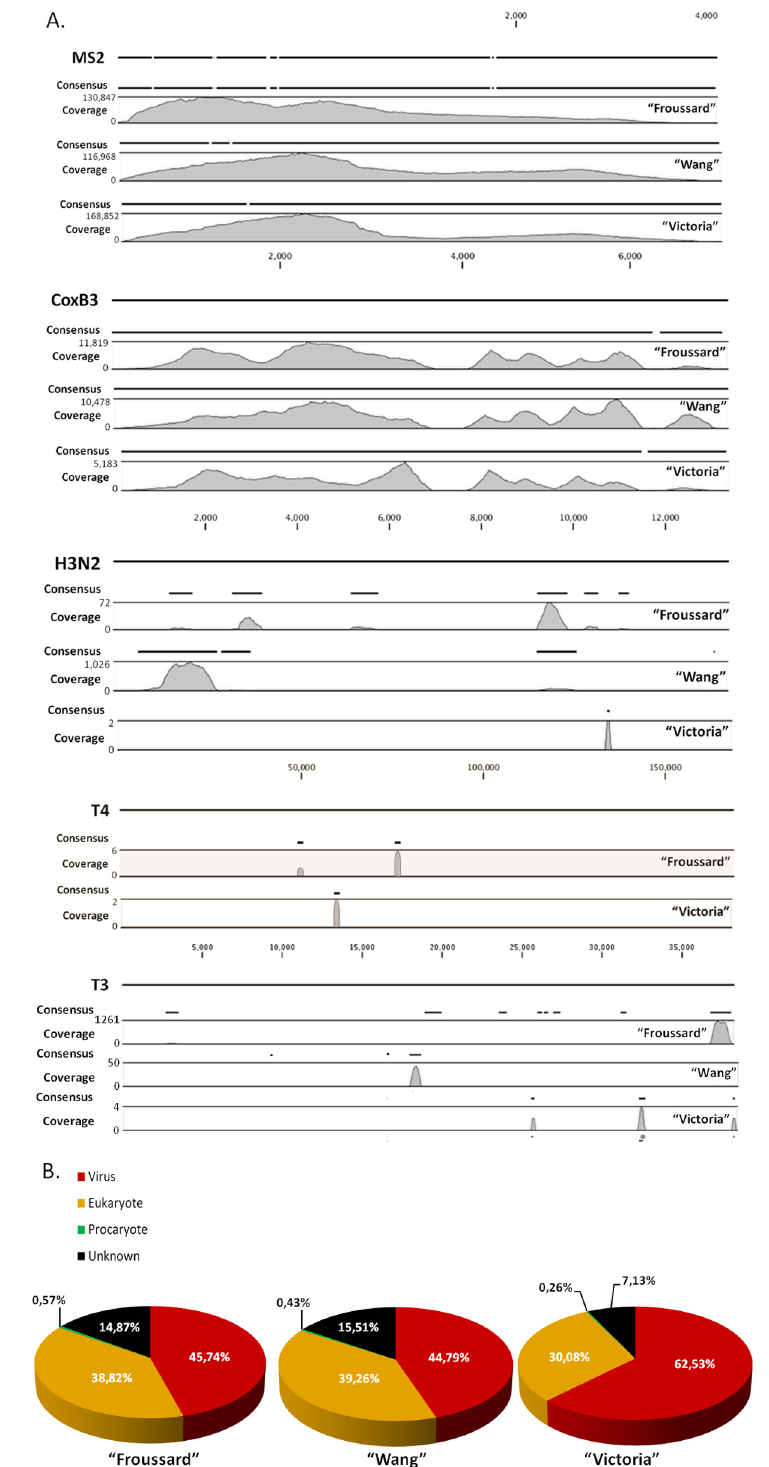
Fig 3. Comparison of the 3 random PCR reactions in engorged lice metagenomes according to: A. reference genome coverage. B. General taxonomic assignment of reads.